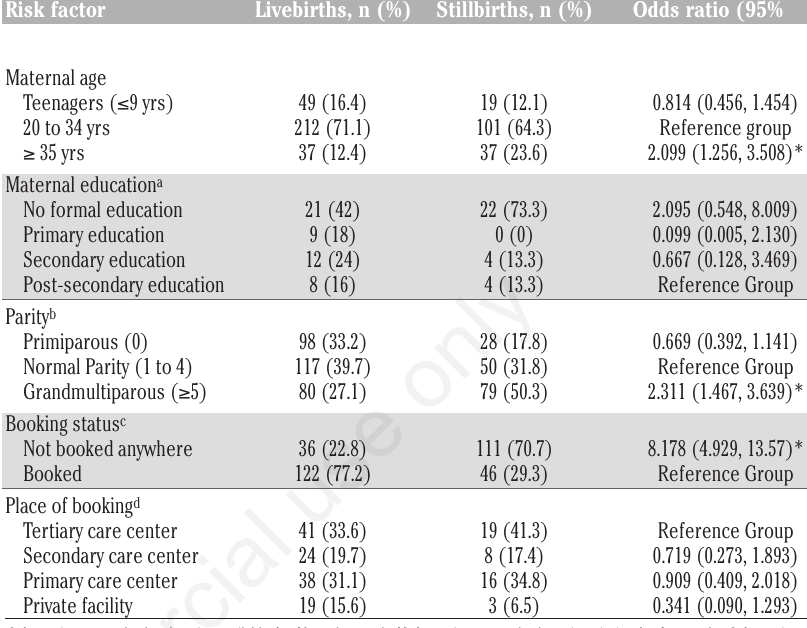
Table 1. Socio-demographic determinants of